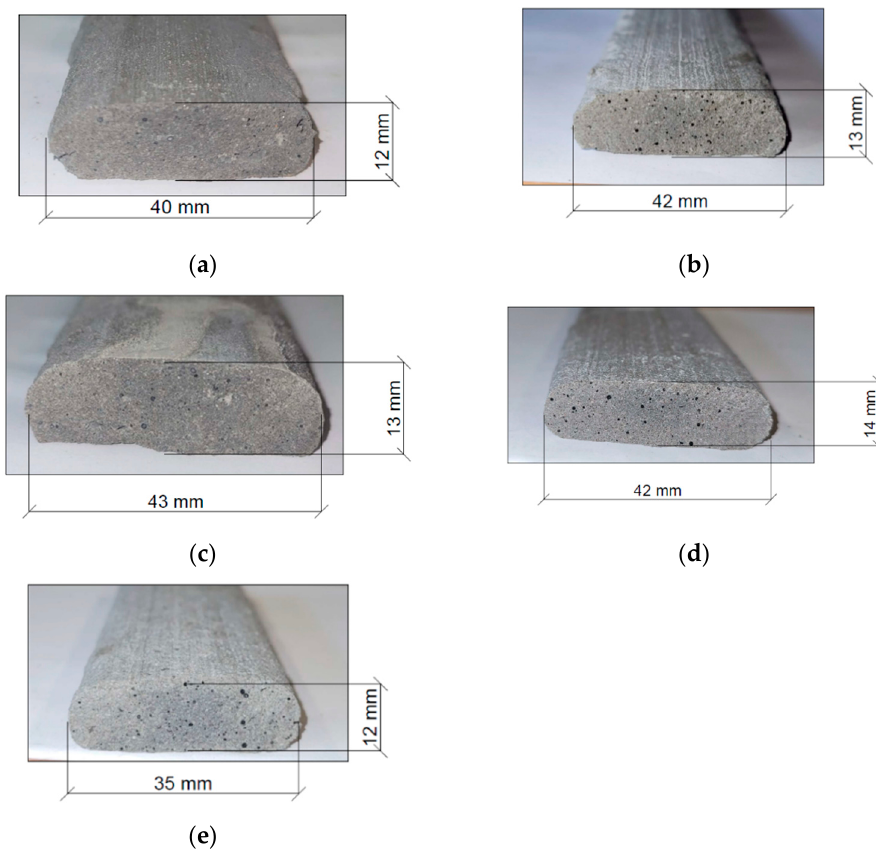
Figure 9. Comparison of path cross ‐ sections: ( a ) OR0; ( b ) OR25; ( c ) OR50; ( d ) OR75; ( e ) OR100.